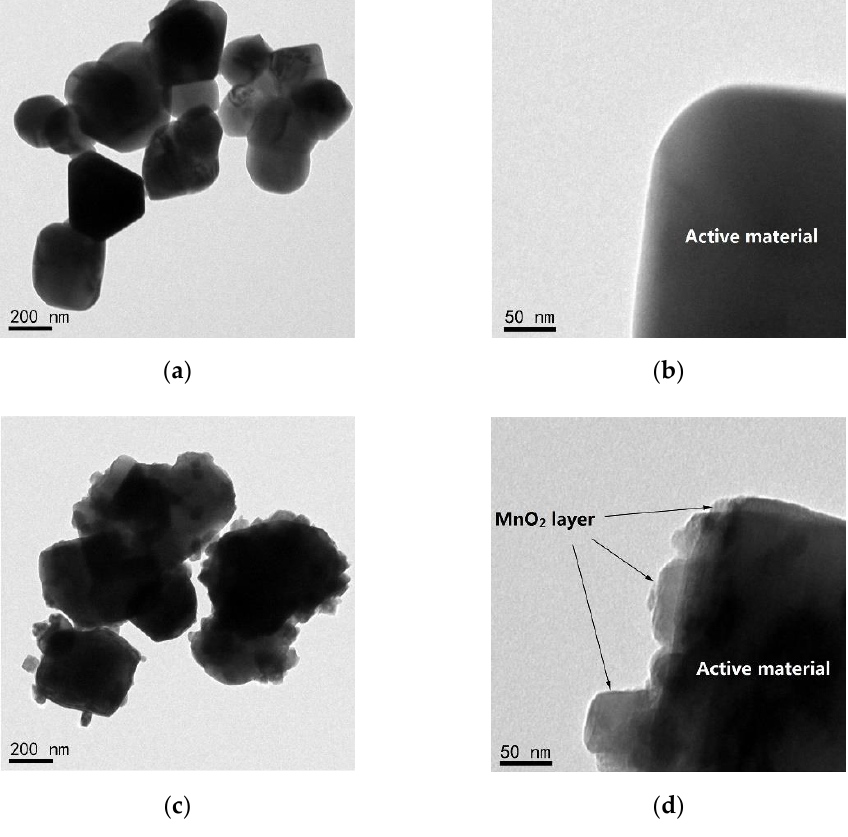
Figure 4. TEM images of the ( a , b ) bare and ( c , d ) MnO 2 -coated LTMO particles.